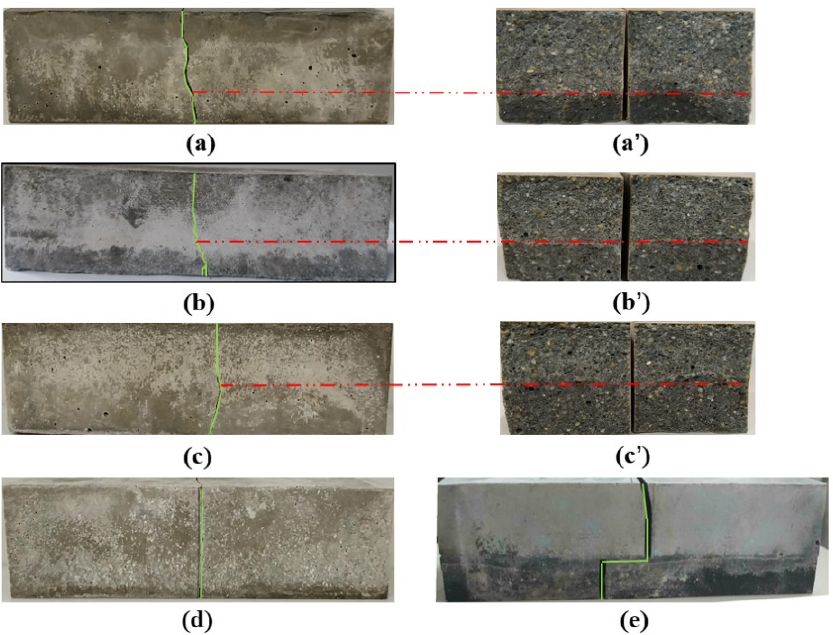
Figure 9. Crack development of samples: ( a ) L8T50, ( b ) L12T50, ( c ) L16T50, ( d ) M, and ( e ) L12T300. Fractured surfaces of samples: ( a’ ) L8T50, ( b’ ) L12T50, ( c’ ) L16T50.